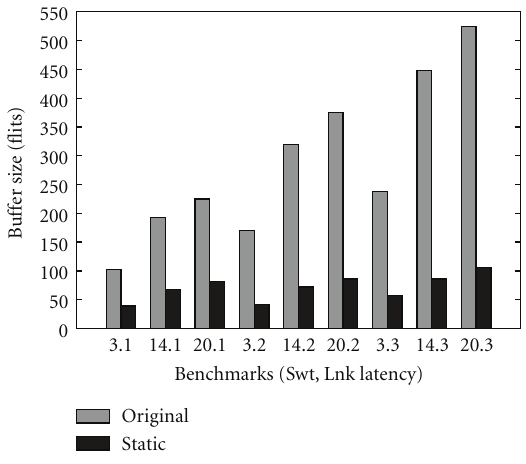
Figure 7: Comparison of bu ff ering schemes.